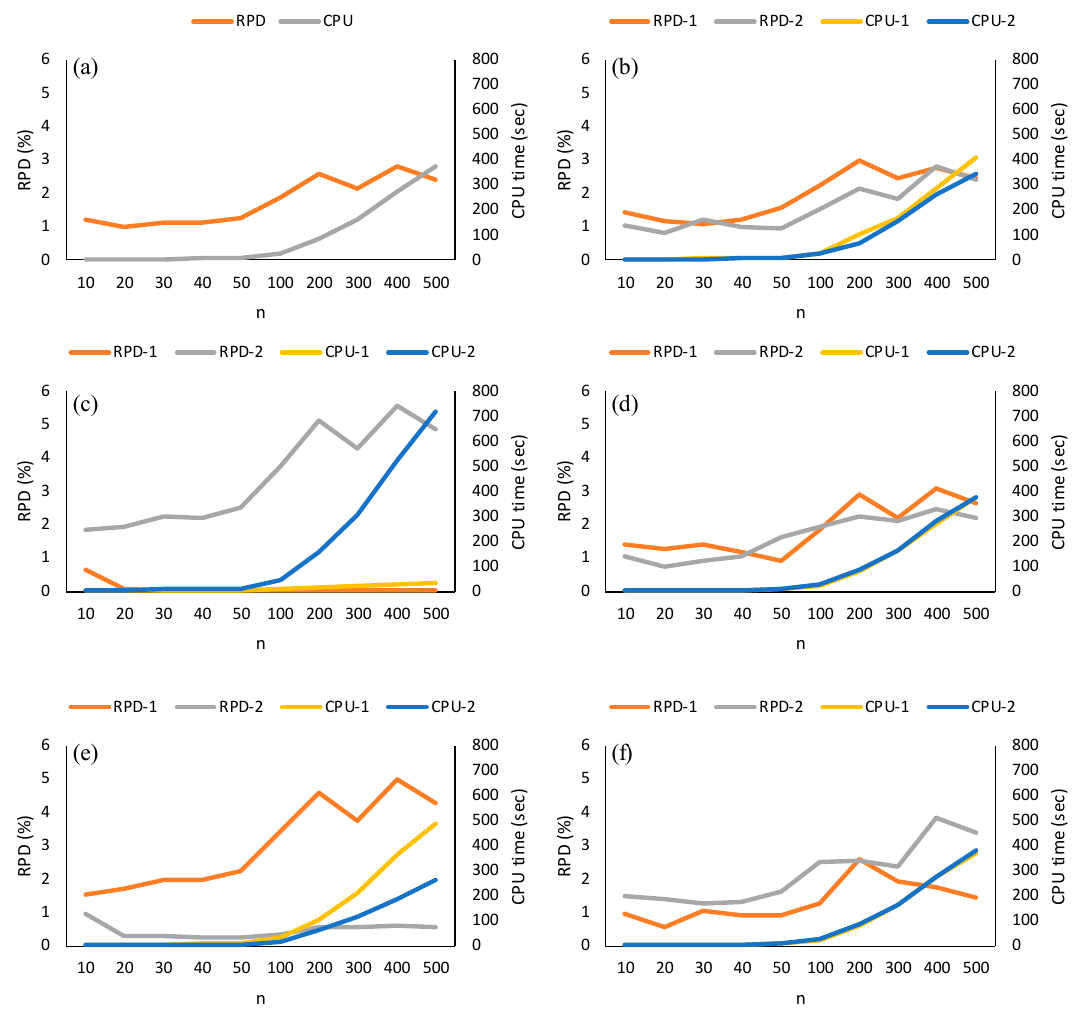
Figure 3. Effects of variables ( a ) number of jobs, 𝑛 ; ( b ) processing times, 𝑝 ; ( c ) ready times, 𝑟 ; ( d ) Figure 3. E ff ects of variables ( a ) number of jobs, n ; ( b ) processing times, p ; ( c ) ready times, r ; ( d ) delivery times, q , ( e ) machine availability time, t ; and ( f ) machine unavailability time, s on the RPD and CPU